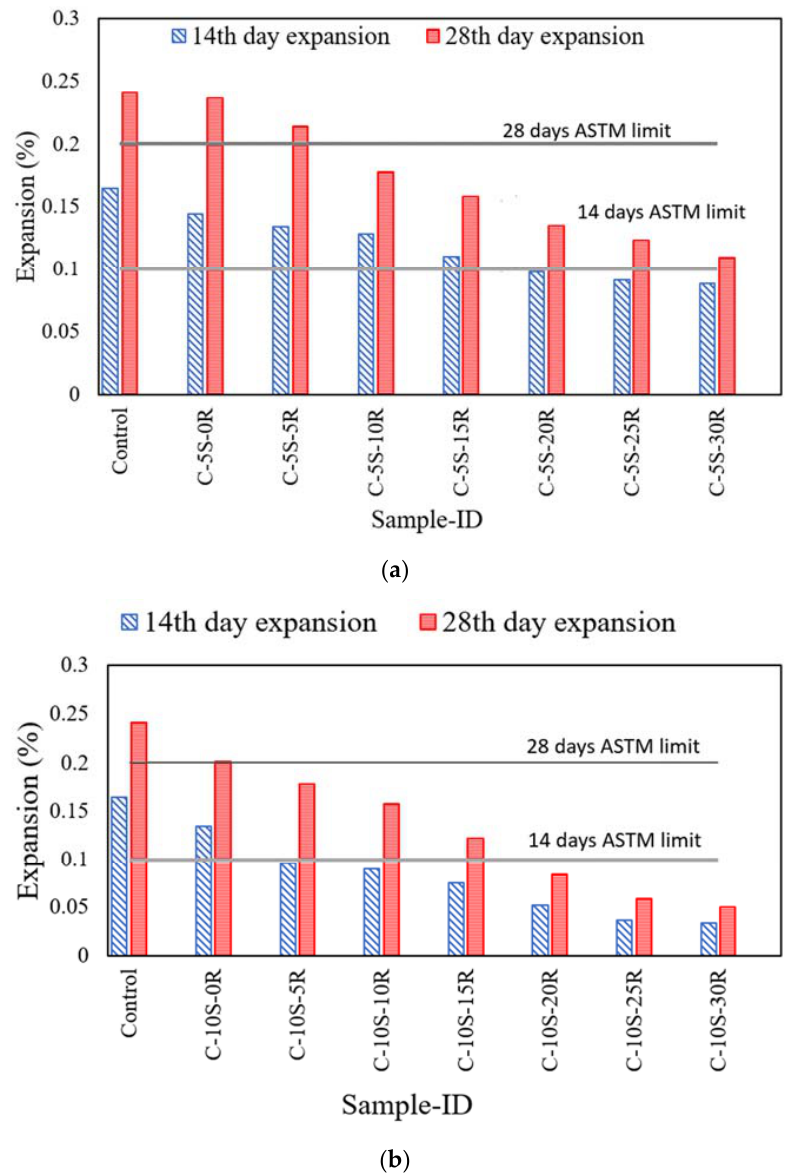
Figure 7. Expansion results of mortar bar incorporating various percentages of SF and